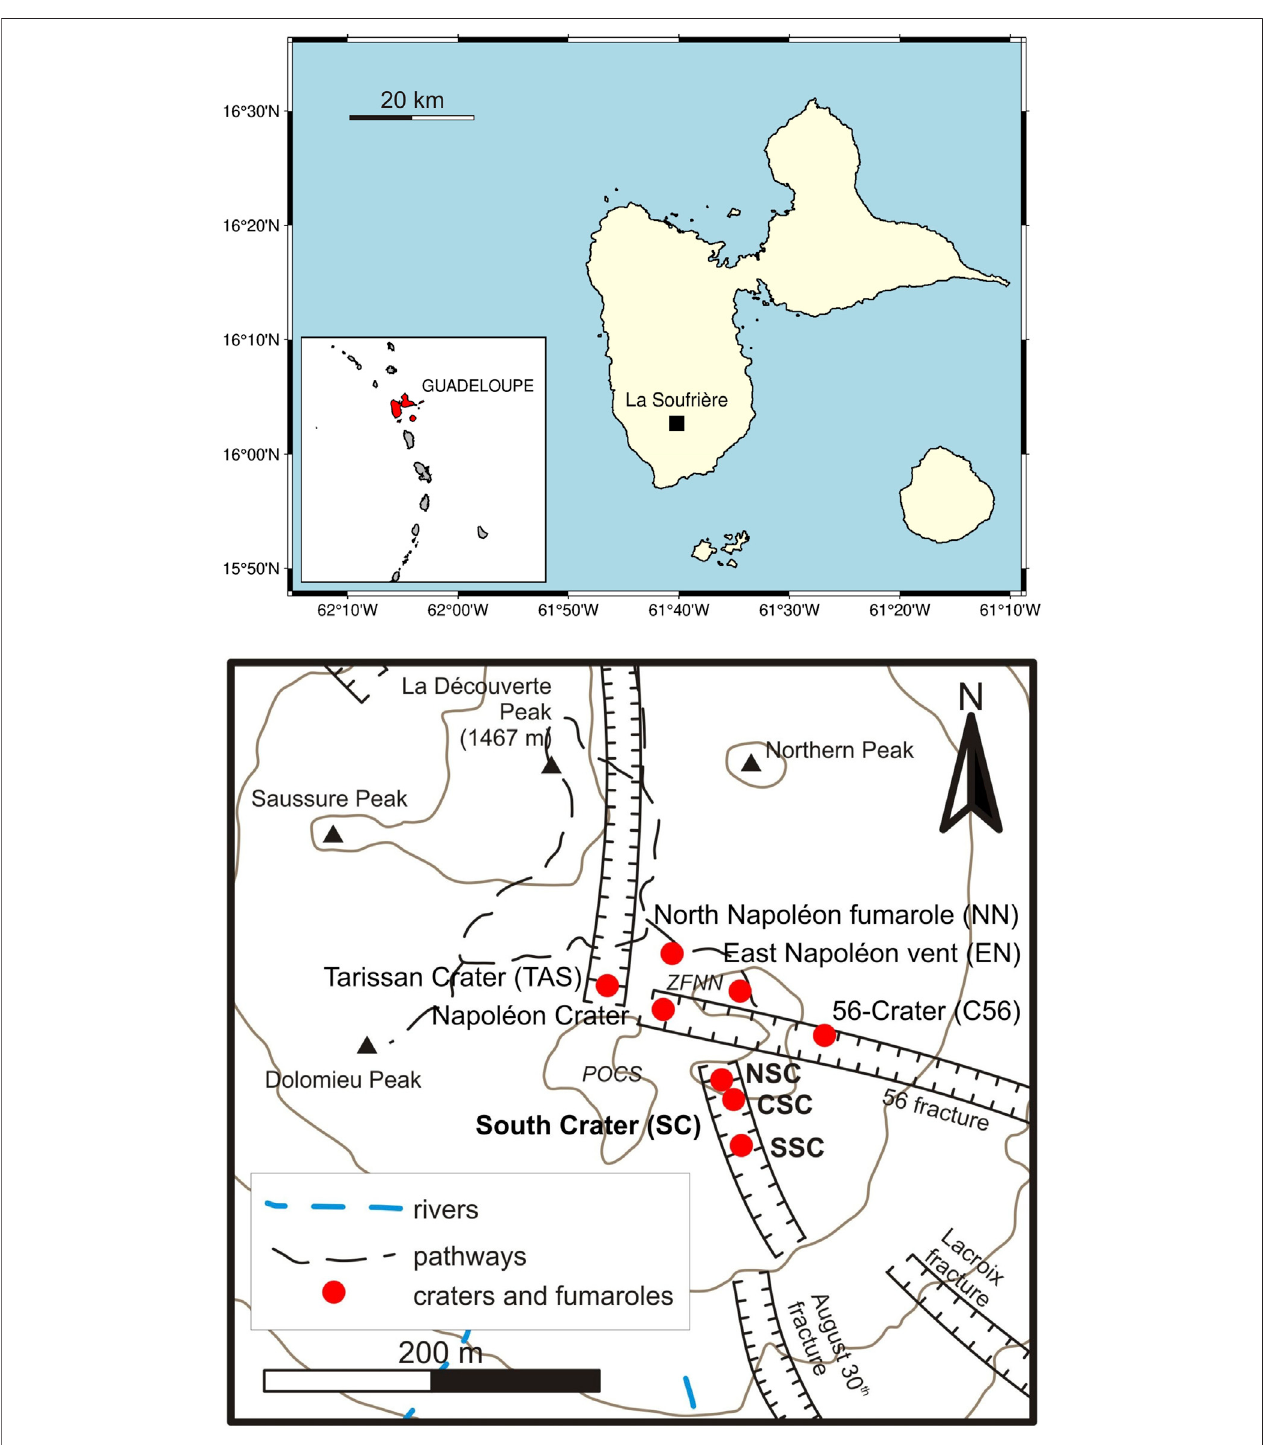
FIGURE1| Top:locationmapofGuadeloupeIslandintheWestIndiesarchipelagoandofLaSoufrièreonGuadeloupe.Bottom:detailedmapofthesummitareaof La Soufrière lava dome. The three active vents within the South Crater (SC) are the northern (NSC), center (CSC) and southern (SSC) craters.